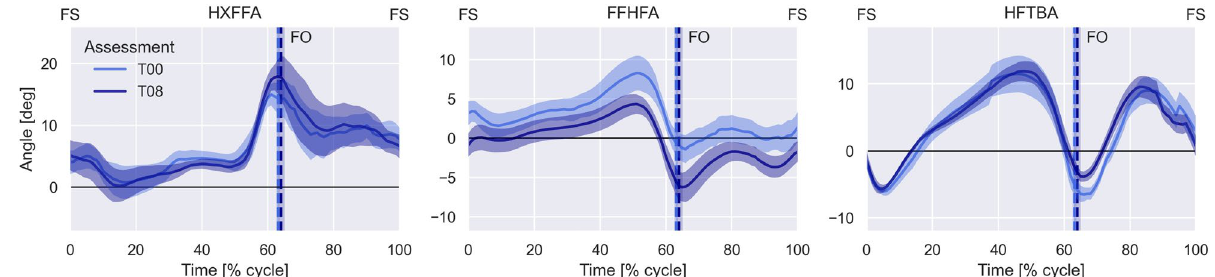
Figure 3. Ensemble averaged kinematics of the hallux (HXFFA), forefoot (FFHFA) and hindfoot (HFTBA) joints in degrees (deg) relative to the proximal segment from de IG participants. Royal blue color indicates baseline assessment (T00), dark blue color indicates Week 8 assessment (T08). Error bars represent standard error. FS indicates foot strike, vertical lines (FO) indicate foot off event in the gait